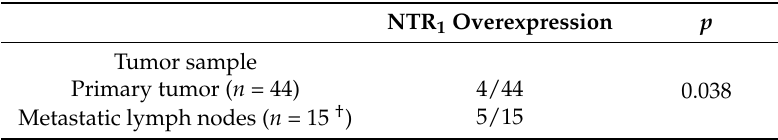
Table 2. NTR 1 expression according to the origin of tumor sample.